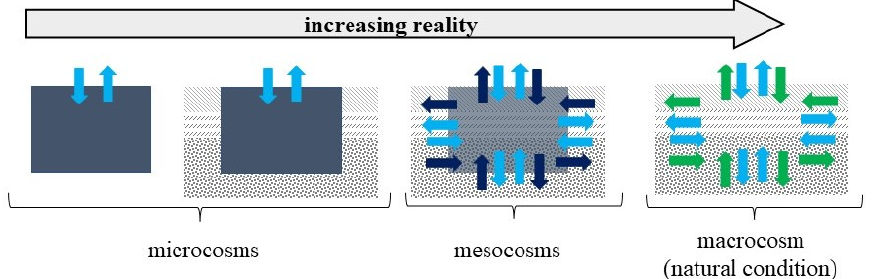
Figure 1. Microcosms, mesocosms and macrocosm in soil analysis. Blue arrows—exchange of com- ponents (e.g., O 2 , CO 2 , water, nutrients); dark blue arrows—controlled movement of soil organisms; green arrows—unrestricted movement of soil organisms. Author’s elaboration based on [19].